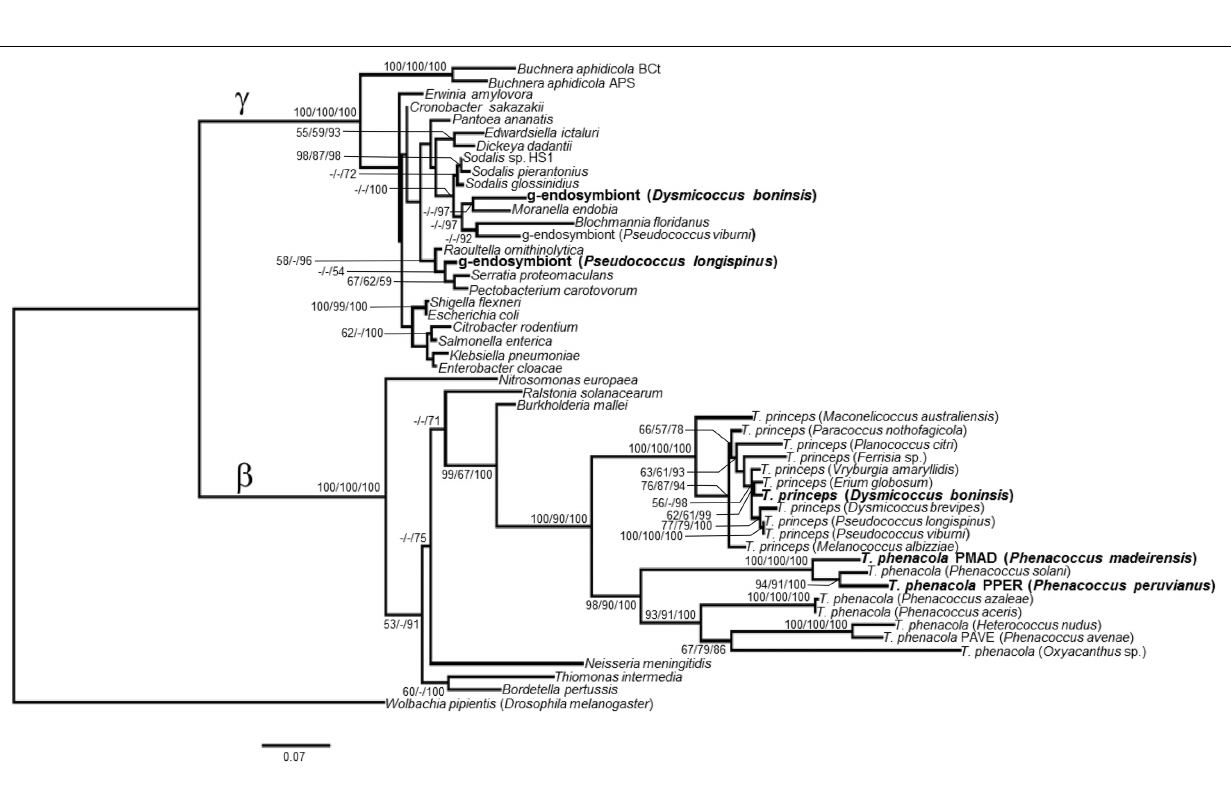
used as outgroup. Bayesian and MP analysis gave essentially the same results. ML and MP bootstrap values, and Bayesian posterior probabilities over 50% are represented. Scale bar represents substitutions per